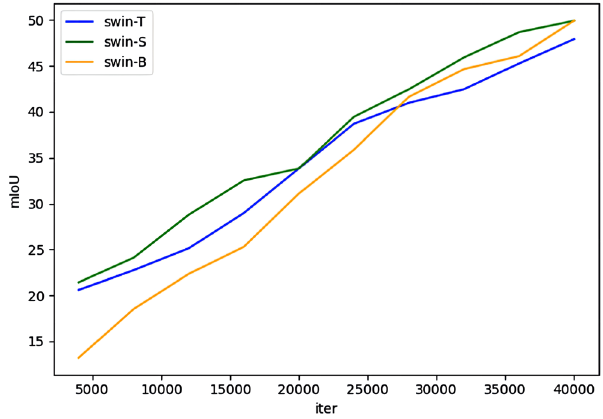
Figure 11. Comparison of mIoU for different models.